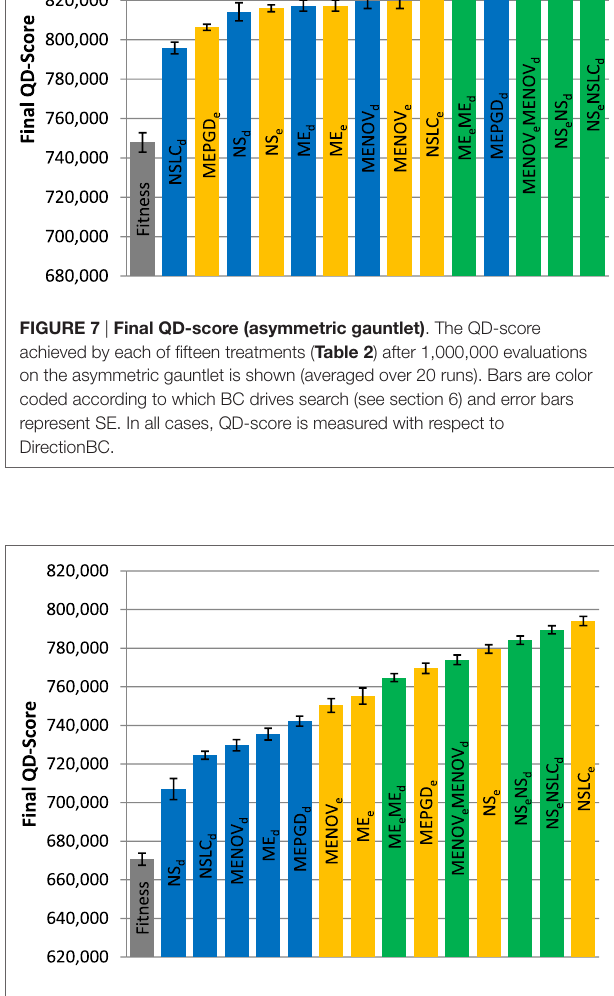
FigUre 8 | Final QD-score (symmetric gauntlet) . The QD-score achieved by each of fifteen treatments ( Table 2 ) after 1,000,000 evaluations on the symmetric gauntlet is shown (averaged over 20 runs). Bars are color coded according to which BC drives search (see section 6) and error bars represent SE. In all cases, QD-score is measured with respect to DirectionBC.